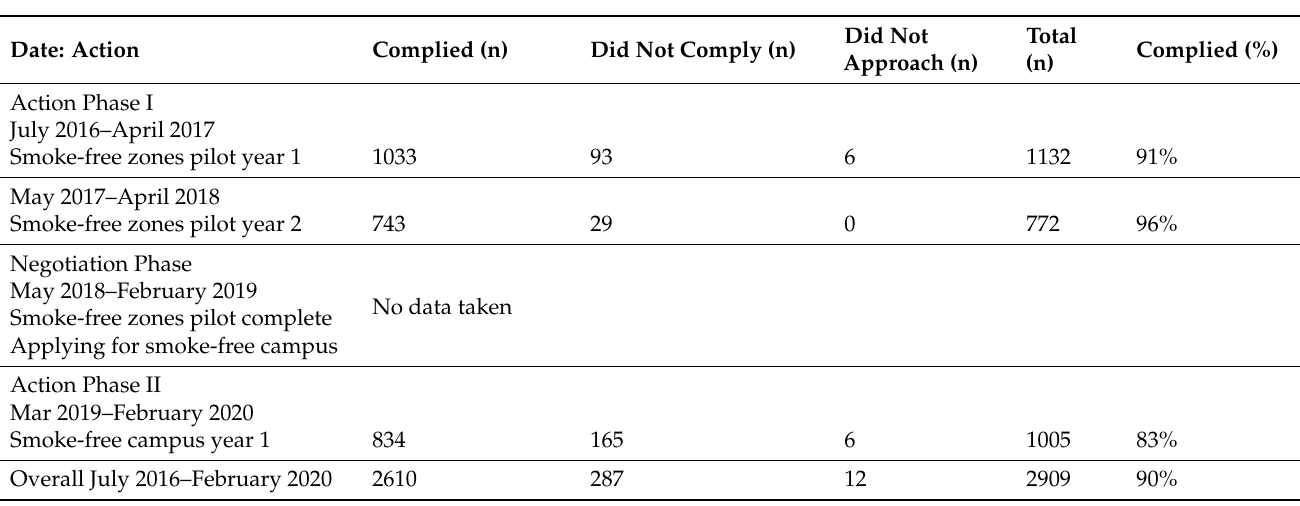
Table 4. Number and percentage of smokers who complied when reminded of the smoke-free policy by time period.